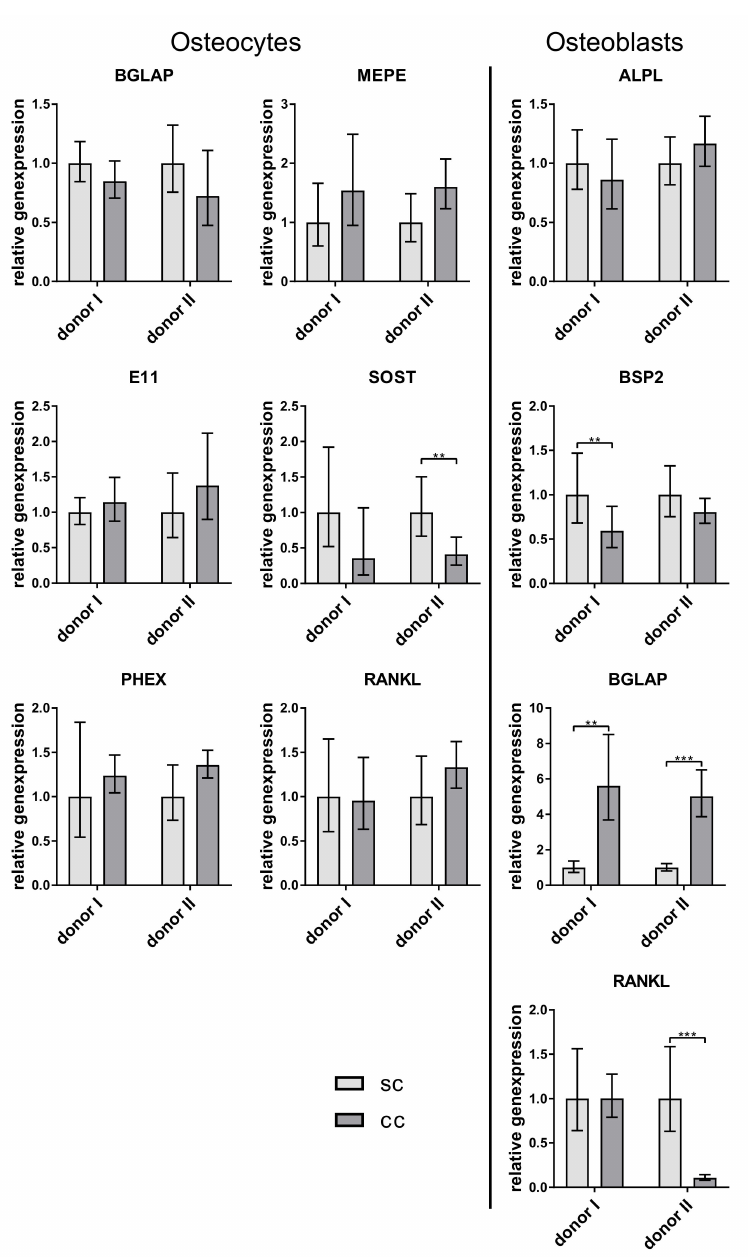
Figure 5. Relative expression of osteocyte and osteoblast markers from single- (sc) and co-cultivated (cc) osteocytes and osteoblasts. Osteocytes were generated by 6 week pre-cultivation of osteoblasts in collagen gels (compare Figure 1B). Data from two di ff erent cell donors are presented in one diagram ( n = 3 replicates / donor): mean ± upper / lower limit. Significant di ff erences to the single culture were defined as ** p < 0.01 and *** p <